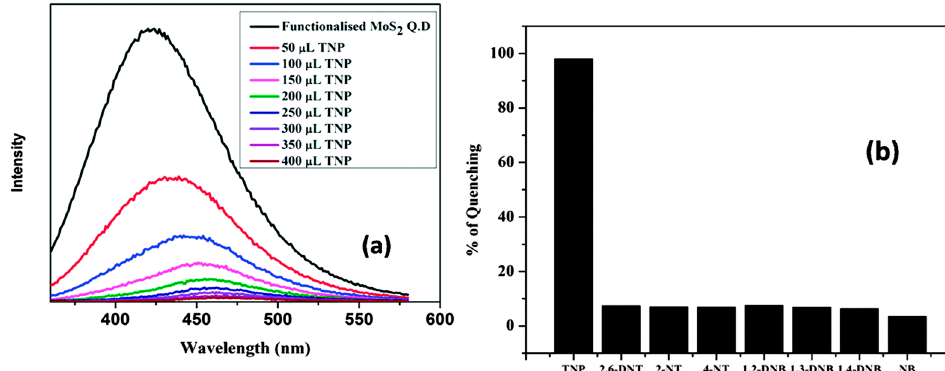
Figure 24. ( a ) Fluorescence quenching of functionalized MoS 2 QDs after gradual addition of different amount of 1 mM TNP solution at buffer 7 and ( b ) quenching efficiency of MoS 2 QDs toward different nitro aromatic compounds after addition of 200 µ L of 1 mM TNP solution at buffer 7. Reproduced with permission from [78]. Copyright The Royal Society of Chemistry, 2016.